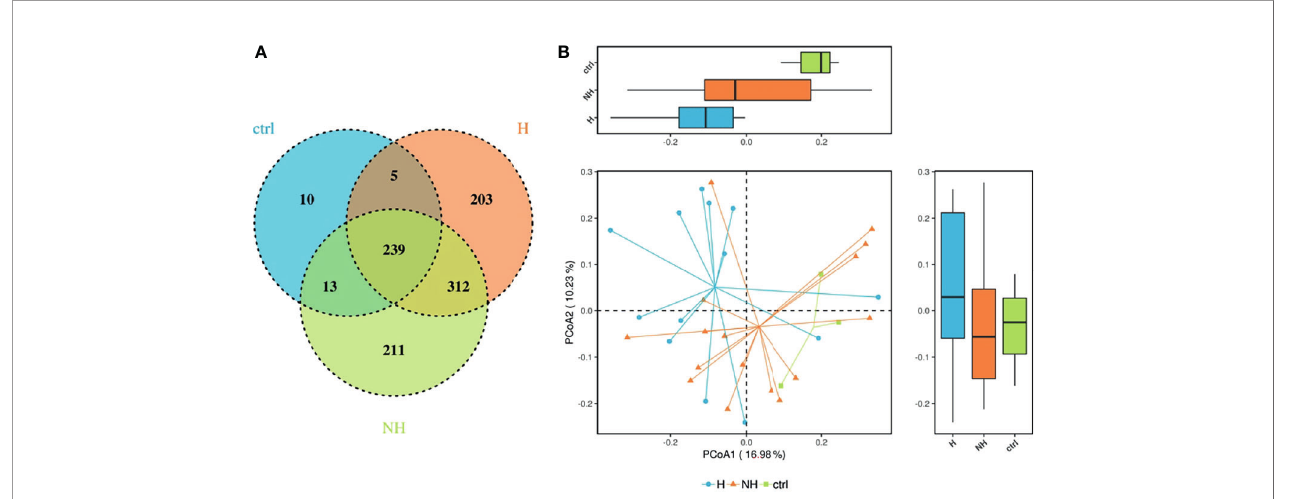
FIGURE 2 | Differential composition of gut microbiome in CRP patients. (A) Venn diagram representing the operational taxonomic units (OTUs) in samples obtained in healthy volunteers (crtl), CRP patients with hematochezia (H), and those without hematochezia (NH). (B) PCoA based on UniFrac matrix showing the differential microbiota composition. Boxes represent the 25th to 75th percentile of the distribution; the median is shown as a thick line in the box.